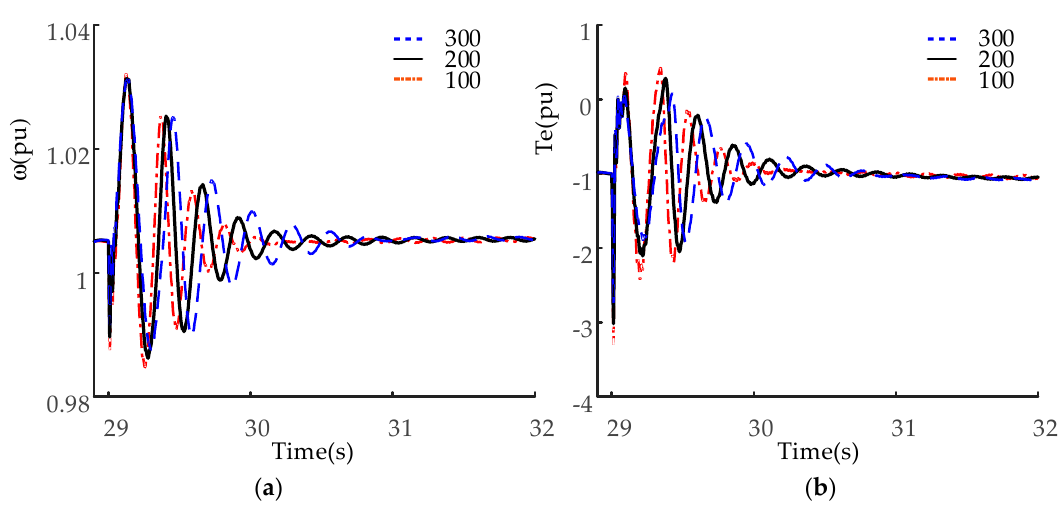
Figure 13. FFT analysis of ( a ) Rotational speed ( b ) Electromagnetic torque ( c ) Mechanical torque for three-phase ground fault in the Base case.